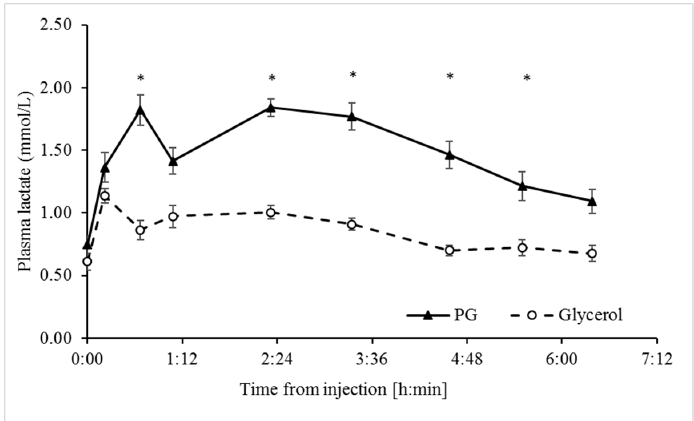
Figure 3. Lactate response to the propylene glycol (PG) and glycerol treatments. Analyses indicate the effects of Treatment, Time, and Treatment × Time interaction (Table 1). * Significant difference at α = 0.00625 after Bonferroni correction. SEM = 13.2. Values represent mean ± SE.